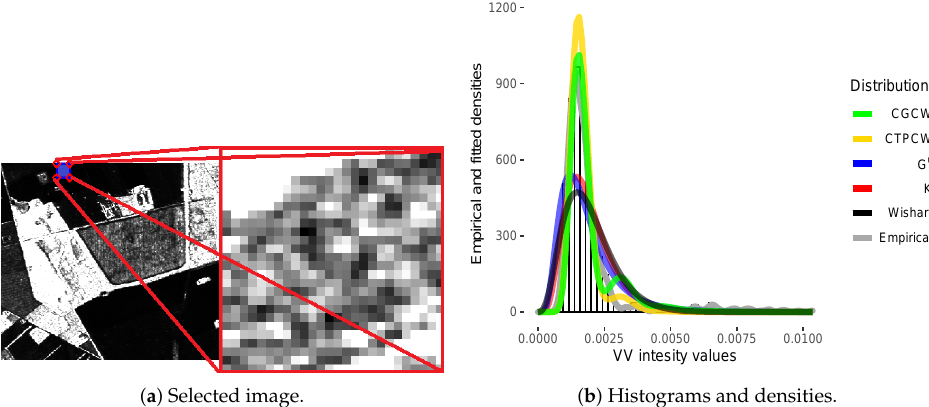
( a ) Selected image. ( b ) Histograms and densities. Figure 12. Selected image and empirical and fitted